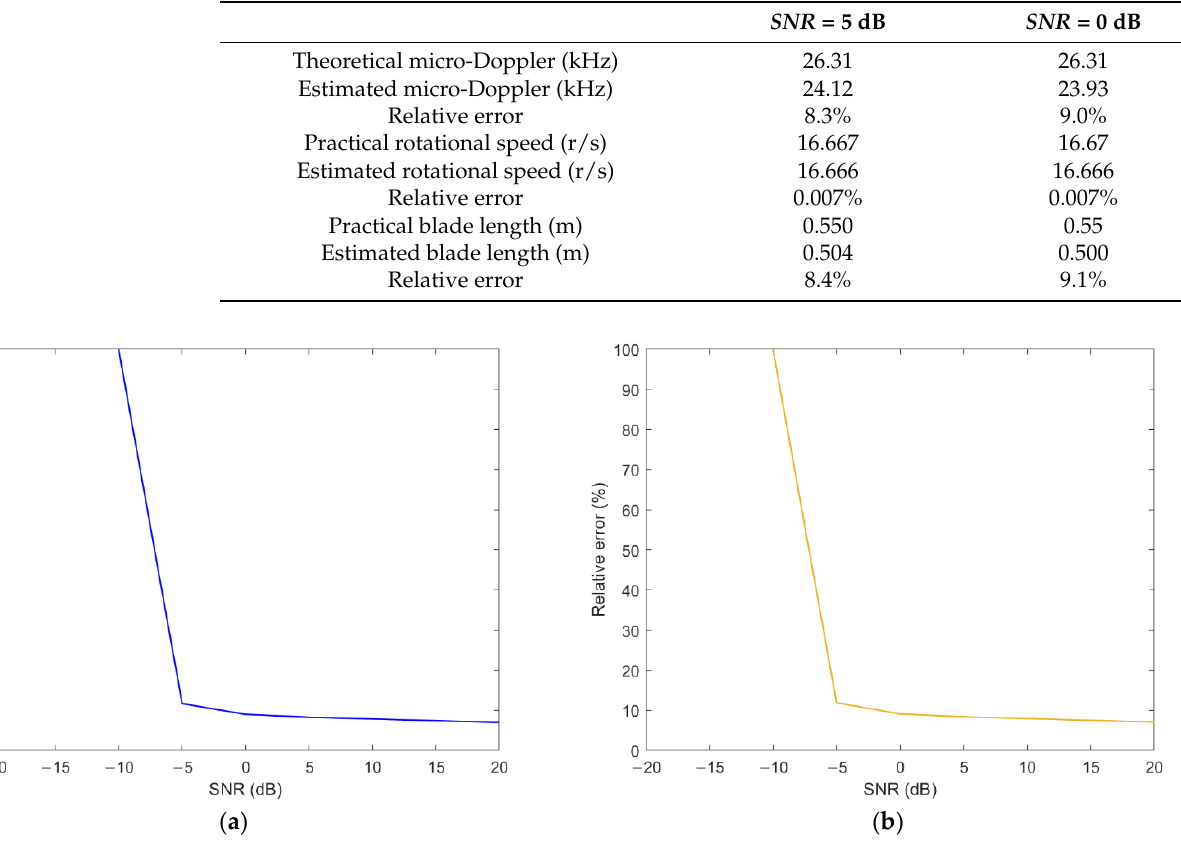
Figure 15. Error curves of turbine parameter estimation: ( a ) Relative error of the estimated maximal micro-Doppler frequency shift. ( b ) Relative error of the estimated blade length.